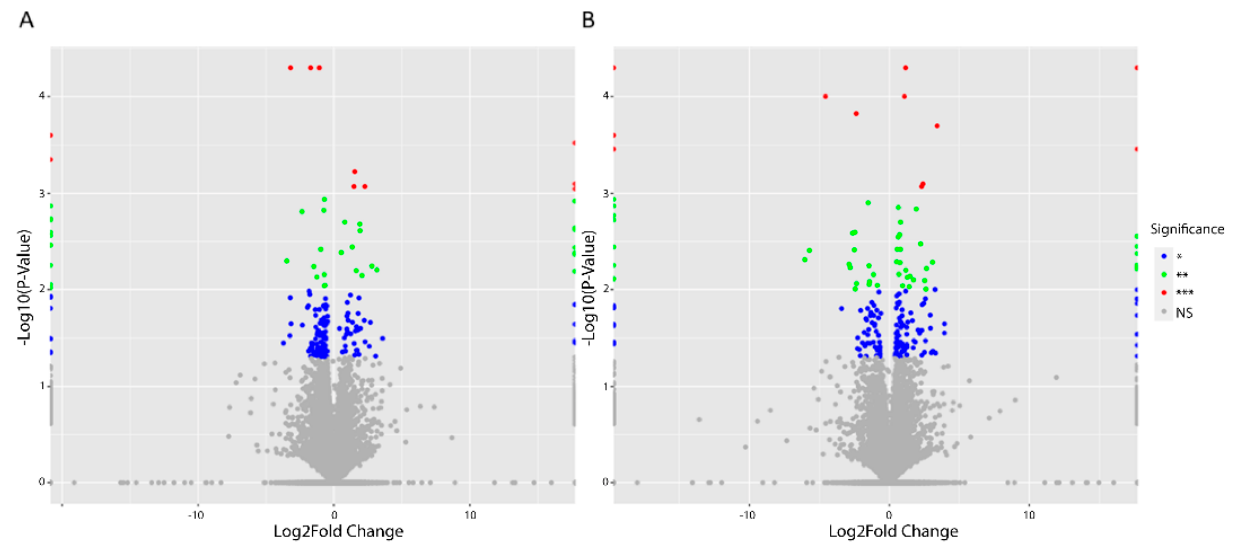
Figure 1. Volcano plots showing differentially regulated genes (DEGs) in SKOV-3 cells treated with 100 nM of asprosin. ( A ) DEGs 4 h post treatment; ( B ) DEGs 12 h following treatment. Significance level is recorded as NS (Non-Significant) = grey; * p < 0.05 = blue; ** p < 0.01 = green; *** p < 0.001 = red.